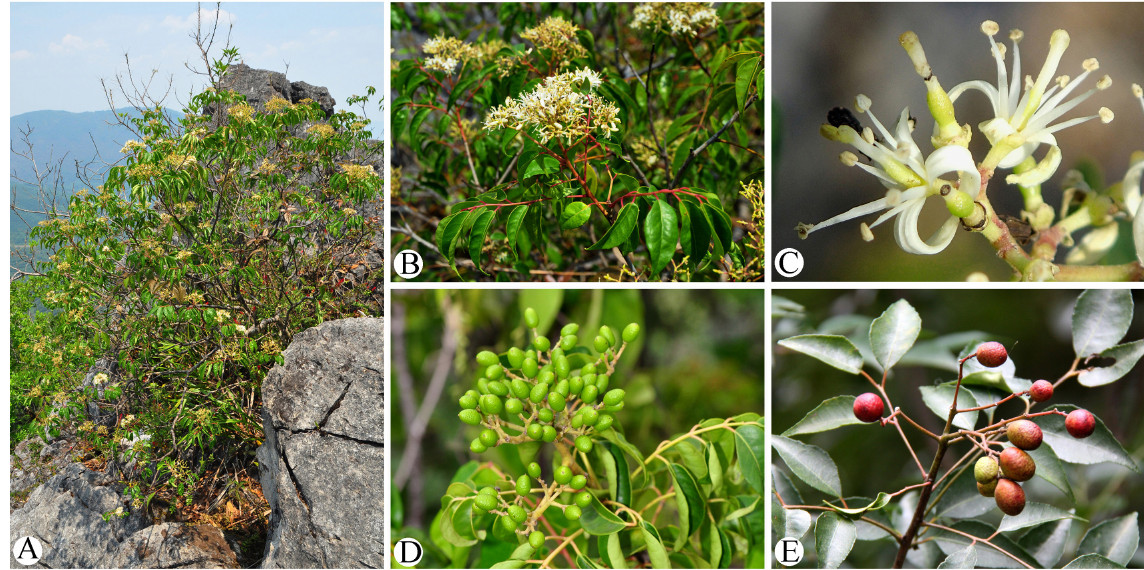
Fig. 13. Bergera tetramera (C.C.Huang) F.J.Mou comb. nov. A . Plants. B . Inflorescence. C . Flowers. D–E . Infructescence. Photos taken by Jian Huang and Feng-Juan Mou in